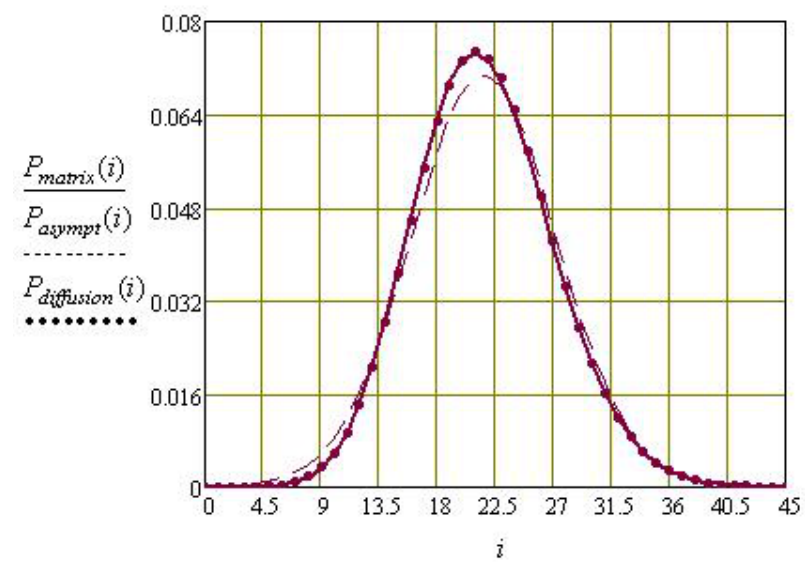
Figure 4. Comparison of the pre-limit (solid line), asymptotic (dashed line), and diffusion (dotted line) distributions for σ = 0.01 and λ = 0.7 ( ∆ AA = 0.0200 and ∆ ADA = 0.0041).